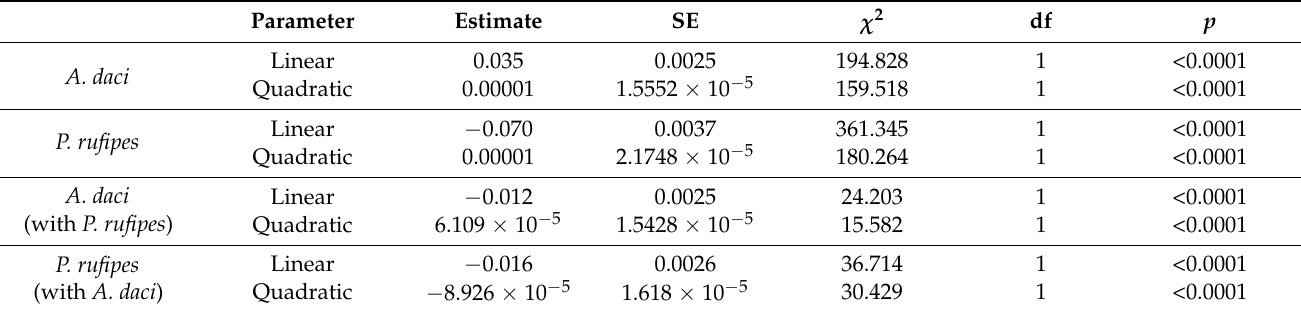
Table 1. Maximum likelihood estimate parameters from the generalized linear model of the proportion of host/prey parasitized/hunted as a function of initial host/prey densities by Aganaspis daci mated females and Pseudoophonus rufipes adults acting alone (Experiments 1 and 2, respectively) and together (Experiment 3) (in all cases, assessed under laboratory conditions).